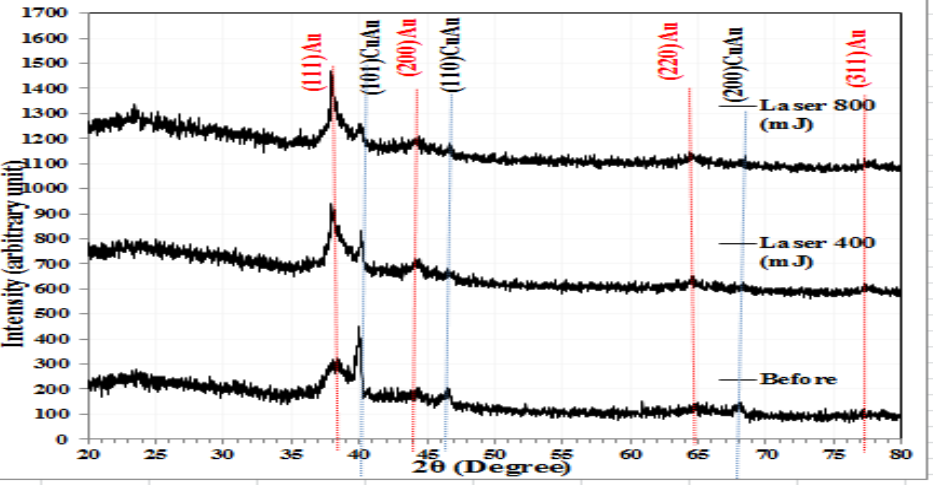
Fig. 7: X-ray diffraction pattern of A-alloy colloid NPs for exploding currents 160A and synthesized by (400 m J, 800 m J) laser energies Irradiation.